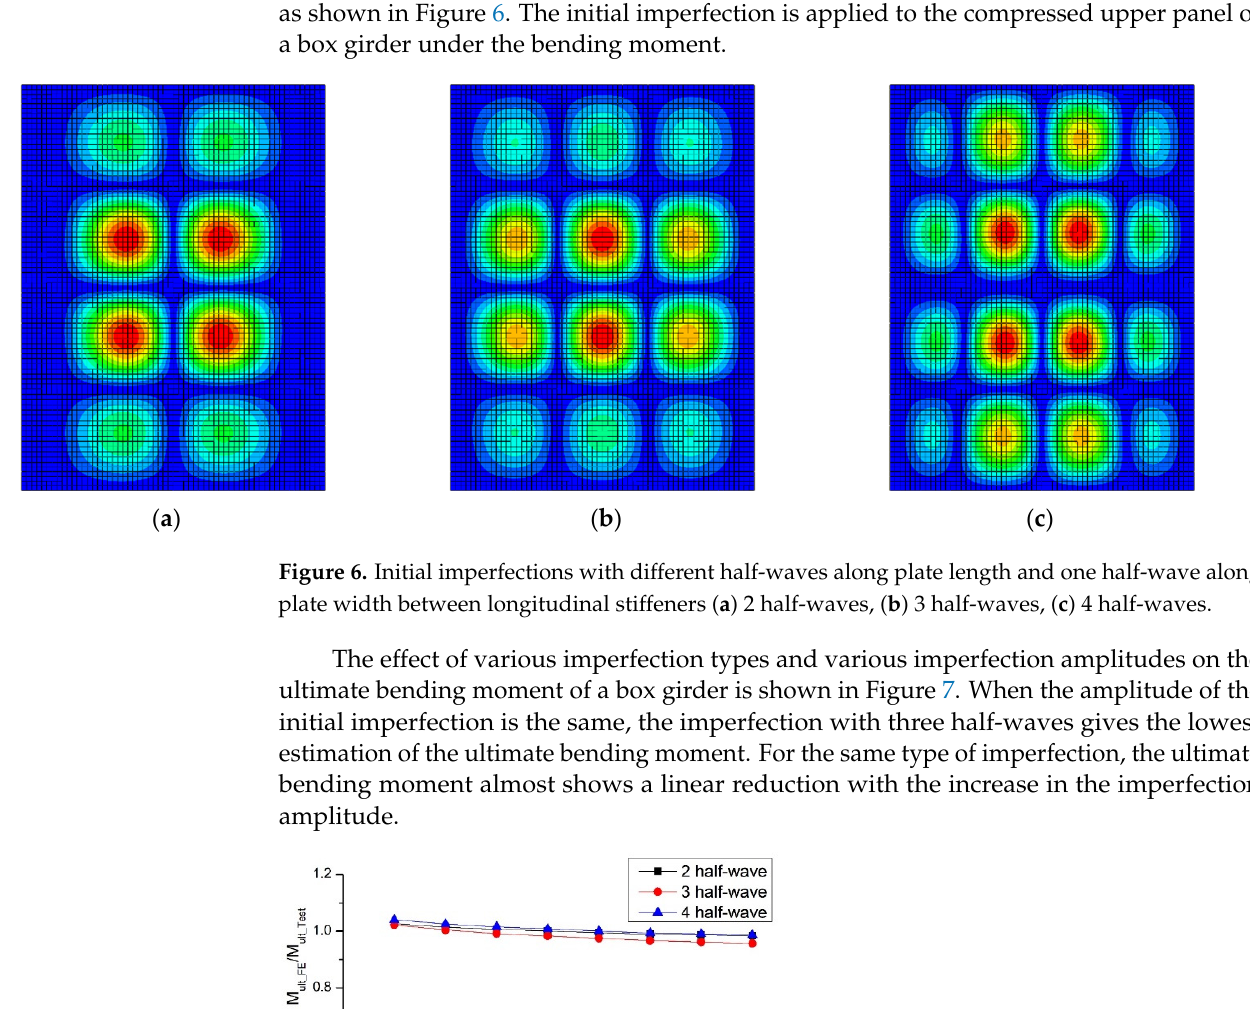
Figure 7. Ultimate bending moment of box girder with various imperfection under static load.